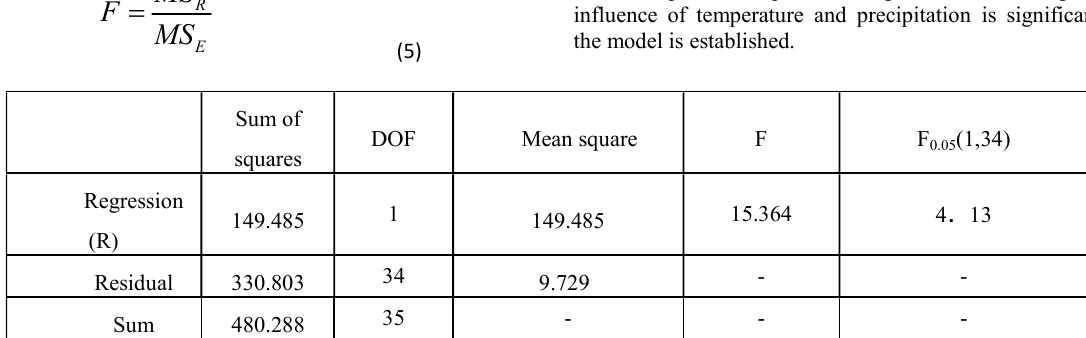
Table 11. Variance analysis table of precipitation from 2014 to